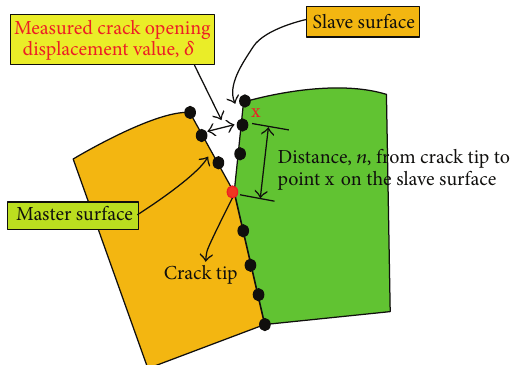
Figure 8: Sketch for the distance specification in